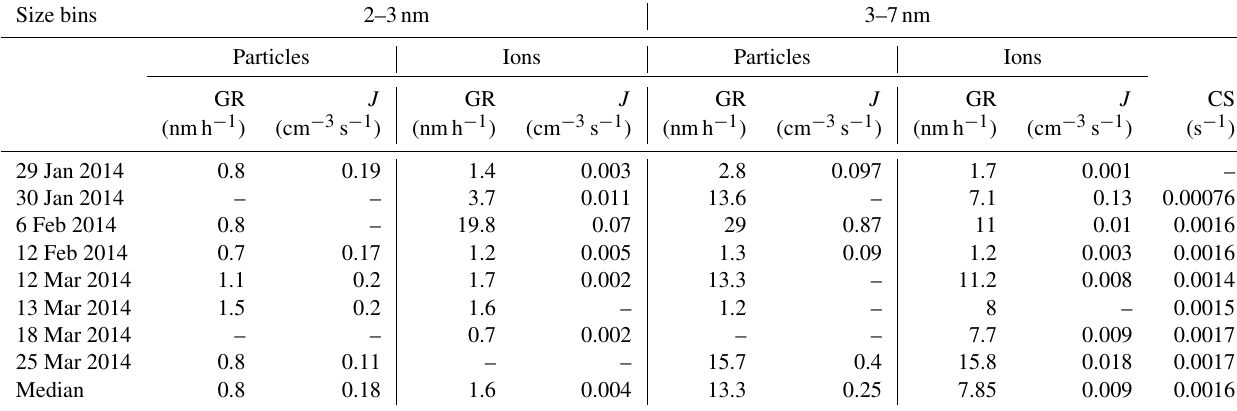
Table 4. The growth rates (GR, nmh − 1 ) and nucleation rates ( J ; cm − 3 s − 1 ) determined from the NAIS ion and particle data for each nucleation event are presented. Both the GR values and the nucleation rates present median values for positive and negative ions. Also, the median values for the calculated condensation sink values (CS; s − 1 ) for each event are shown. The condensation sink parameter is calculated from the SMPS size distributions. The last line of the table shows the median values for GR and J for all the nucleation event days, except the ion GR at 2–3nm of 19.8nmh − 1 on 6 February 2014, which is considered to be an outlier and not included in the